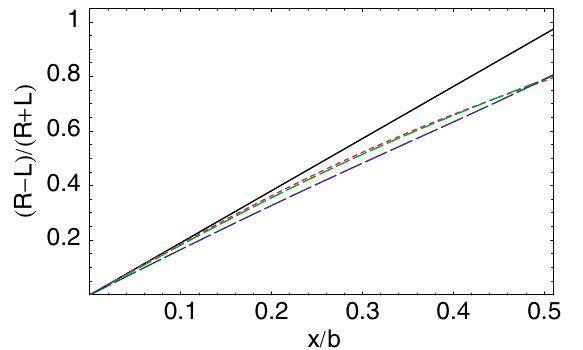
(cid:3) 0 . =w (cid:3) 0 : 1 , (cid:7) x y